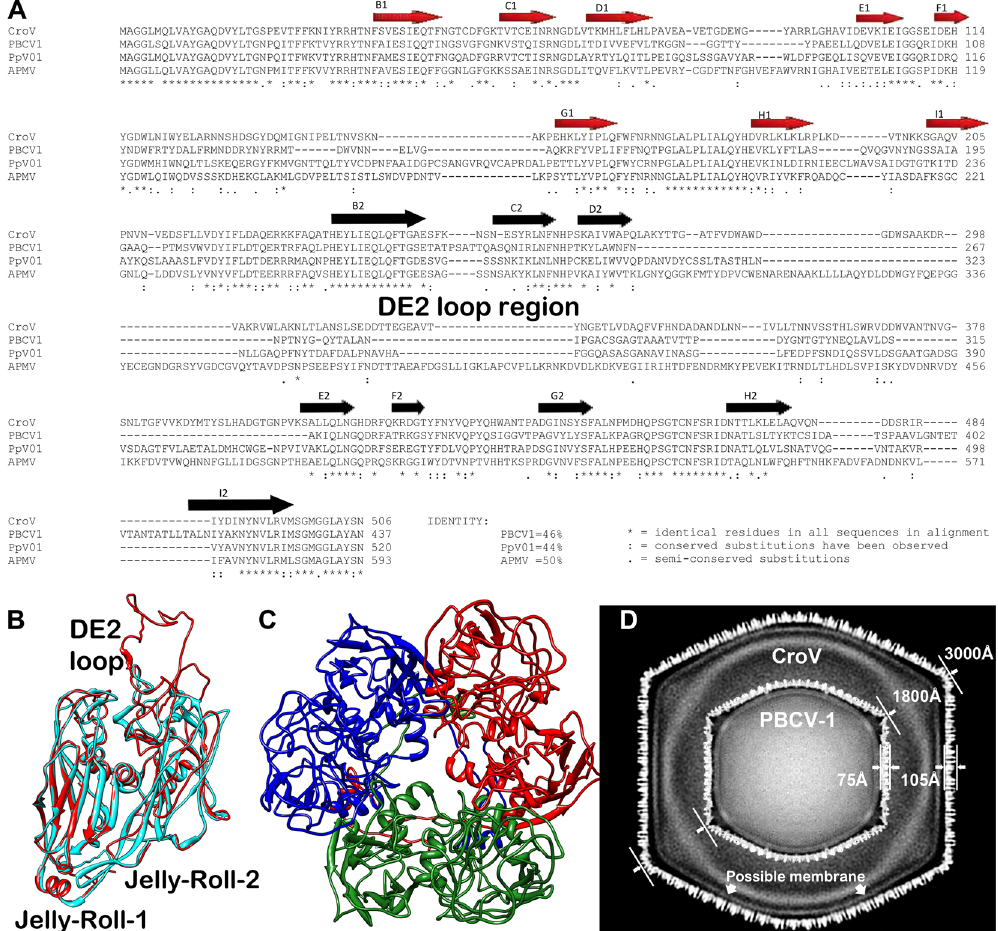
Figure 3. The double jelly-roll major capsid protein (MCP) of large icosahedral viruses. ( A ) Multiple sequence alignment of the MCPs of CroV, PBCV-1, PpV01 and APMV. Both CroV and APMV have large DE2 loops. ( B ) The CroV MCP (red) was homologously modeled and superposed with the X-ray structure of PBCV-1 (cyan) to show the longer DE2 loop of CroV. ( C ) Ribbon diagram of the trimeric homologously modeled CroV double jelly-roll MCP capsomer displaying a pseudo-hexagonal shape. Individual double jelly-roll MCPs are color-coded. ( D ) Central cross-section of the cryo-EM map of CroV superposed with that of PBCV-1. CroV not only has a larger virion diameter (3000 Å vs 1800 Å), its capsid layer is also thicker (105 Å vs 75 Å), which is consistent with the extended DE2 loop shown in panel